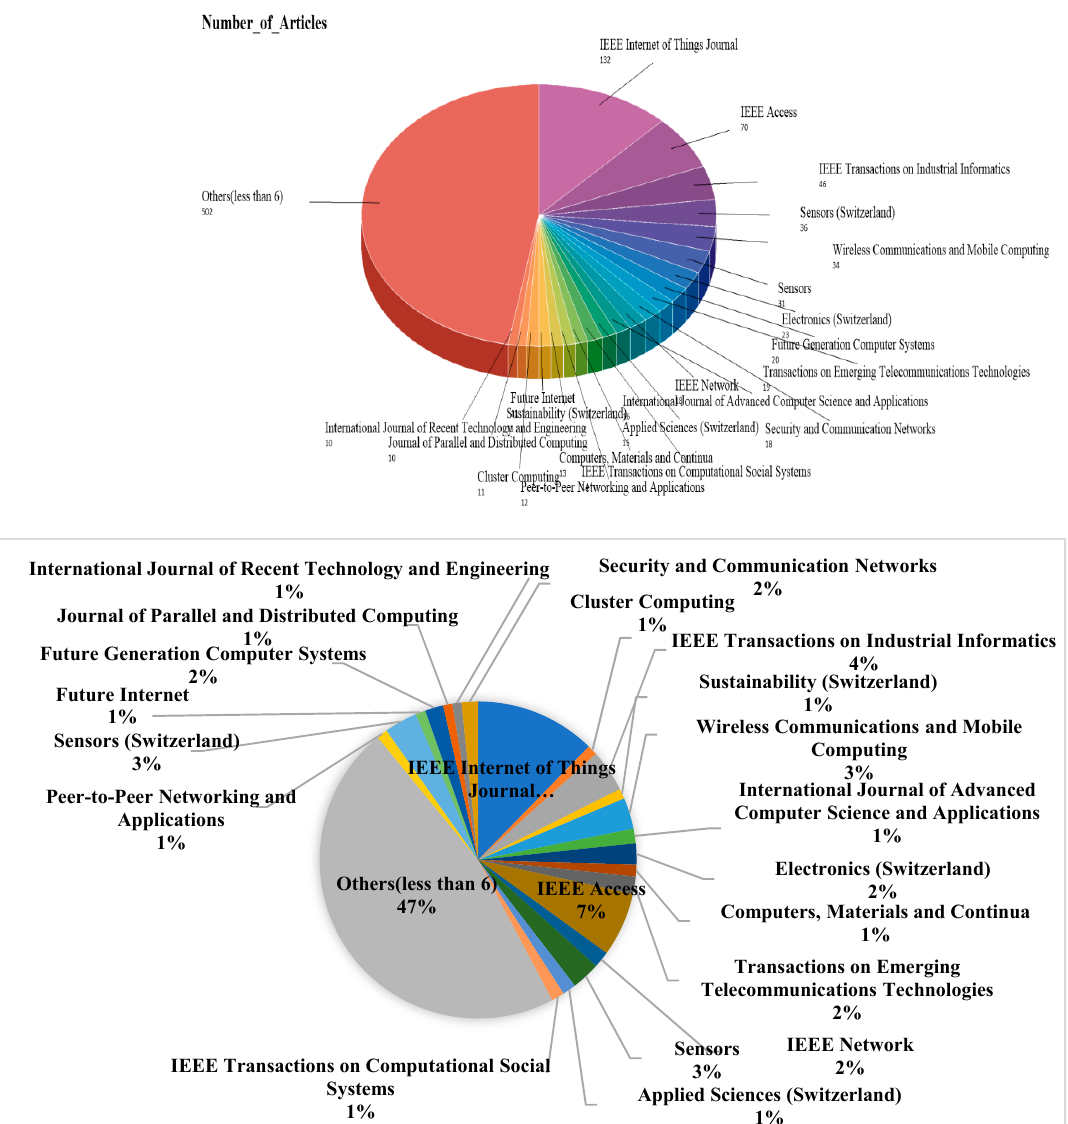
Figure 3. Distribution based on the type of source. Table 8. Analysis of articles published by the journal.